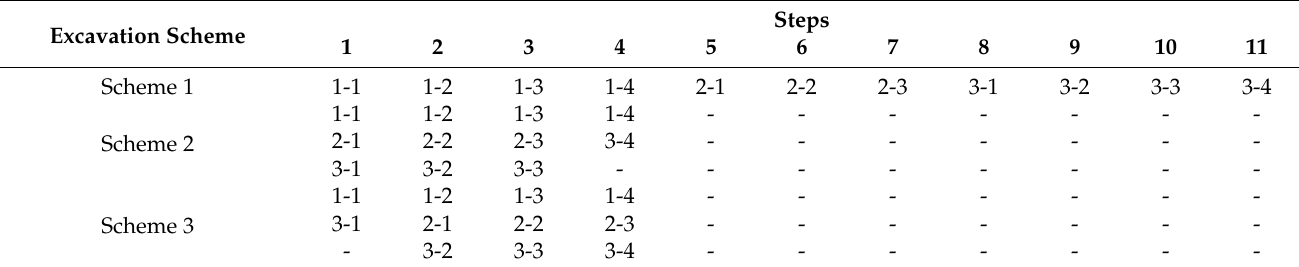
Table 2. Excavation